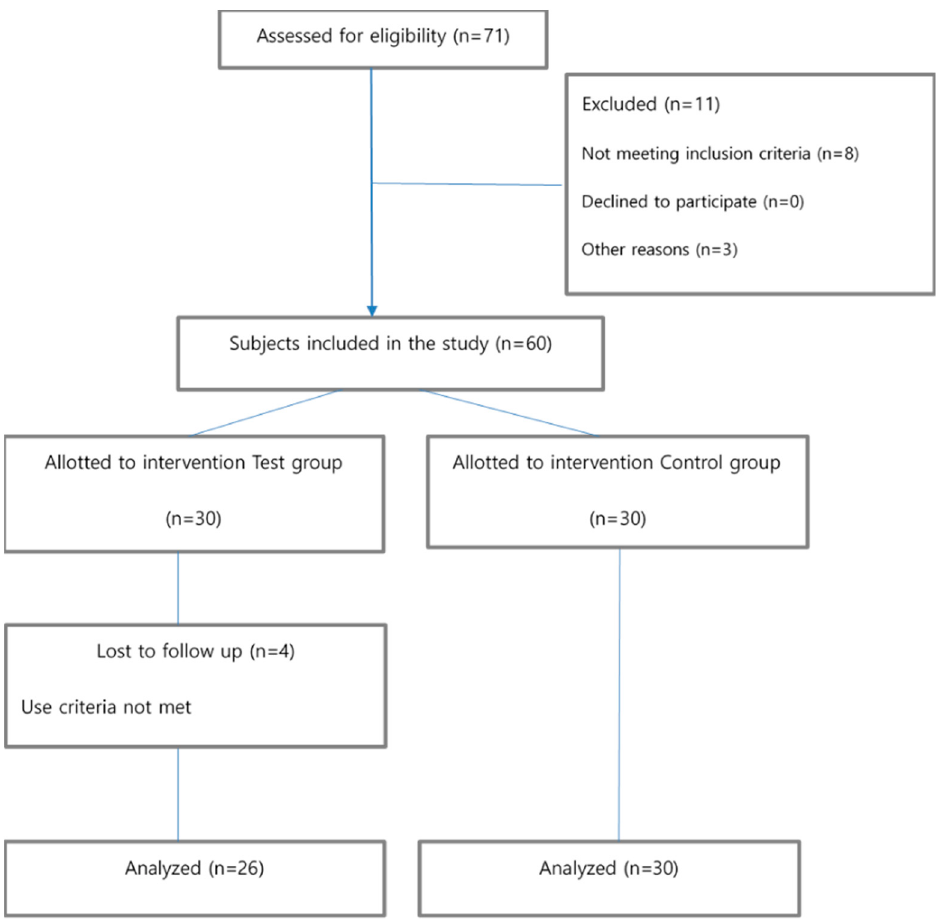
Figure 1. Flowchart of the study design process.